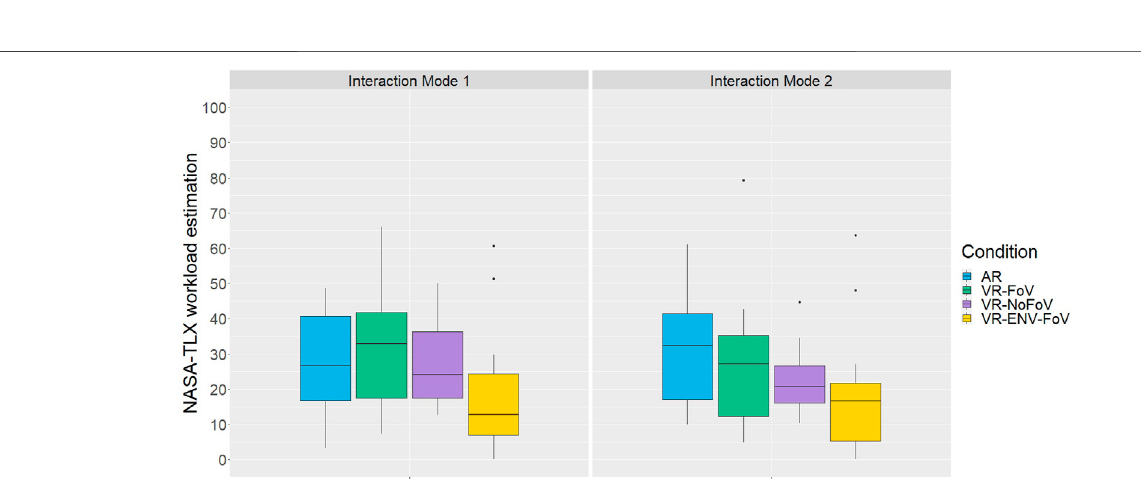
Frontiers in Virtual Reality |